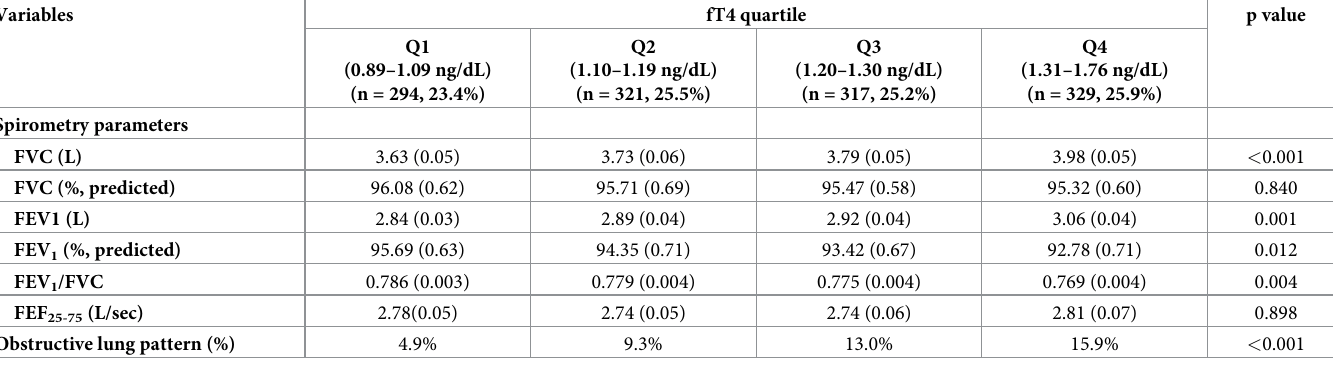
Table 2. Comparison of spirometry data according to free thyroxine quartiles. Variables